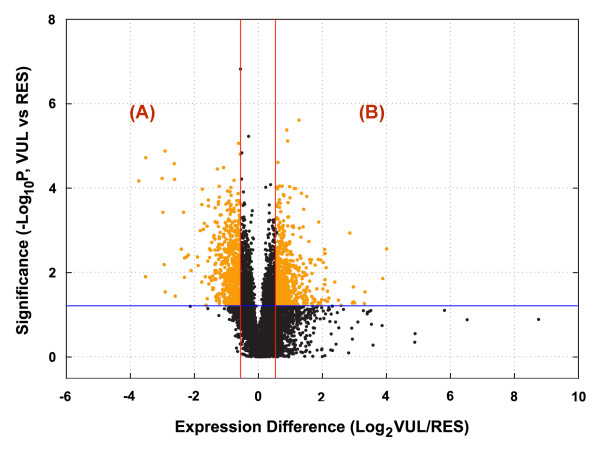
Identification of differentially expressed genes (orange colored) between the vulnerable (VUL) and resistant (RES) groups by volcano plot. The Y-axis displays the negative log (base 10) of P values from paired t-tests, while the X-axis shows the log (base 2) of the -fold differences between the two groups (VUL/RES). The blue line represents the P = 0.05 value, and the red lines correspond to fold differences of 1.5 and -1.5, respectively. Genes with paired t-test P < 0.05, and fold difference ≥1.5 or ≤-1.5, were identified as differentially expressed genes and are highlighted in orange.